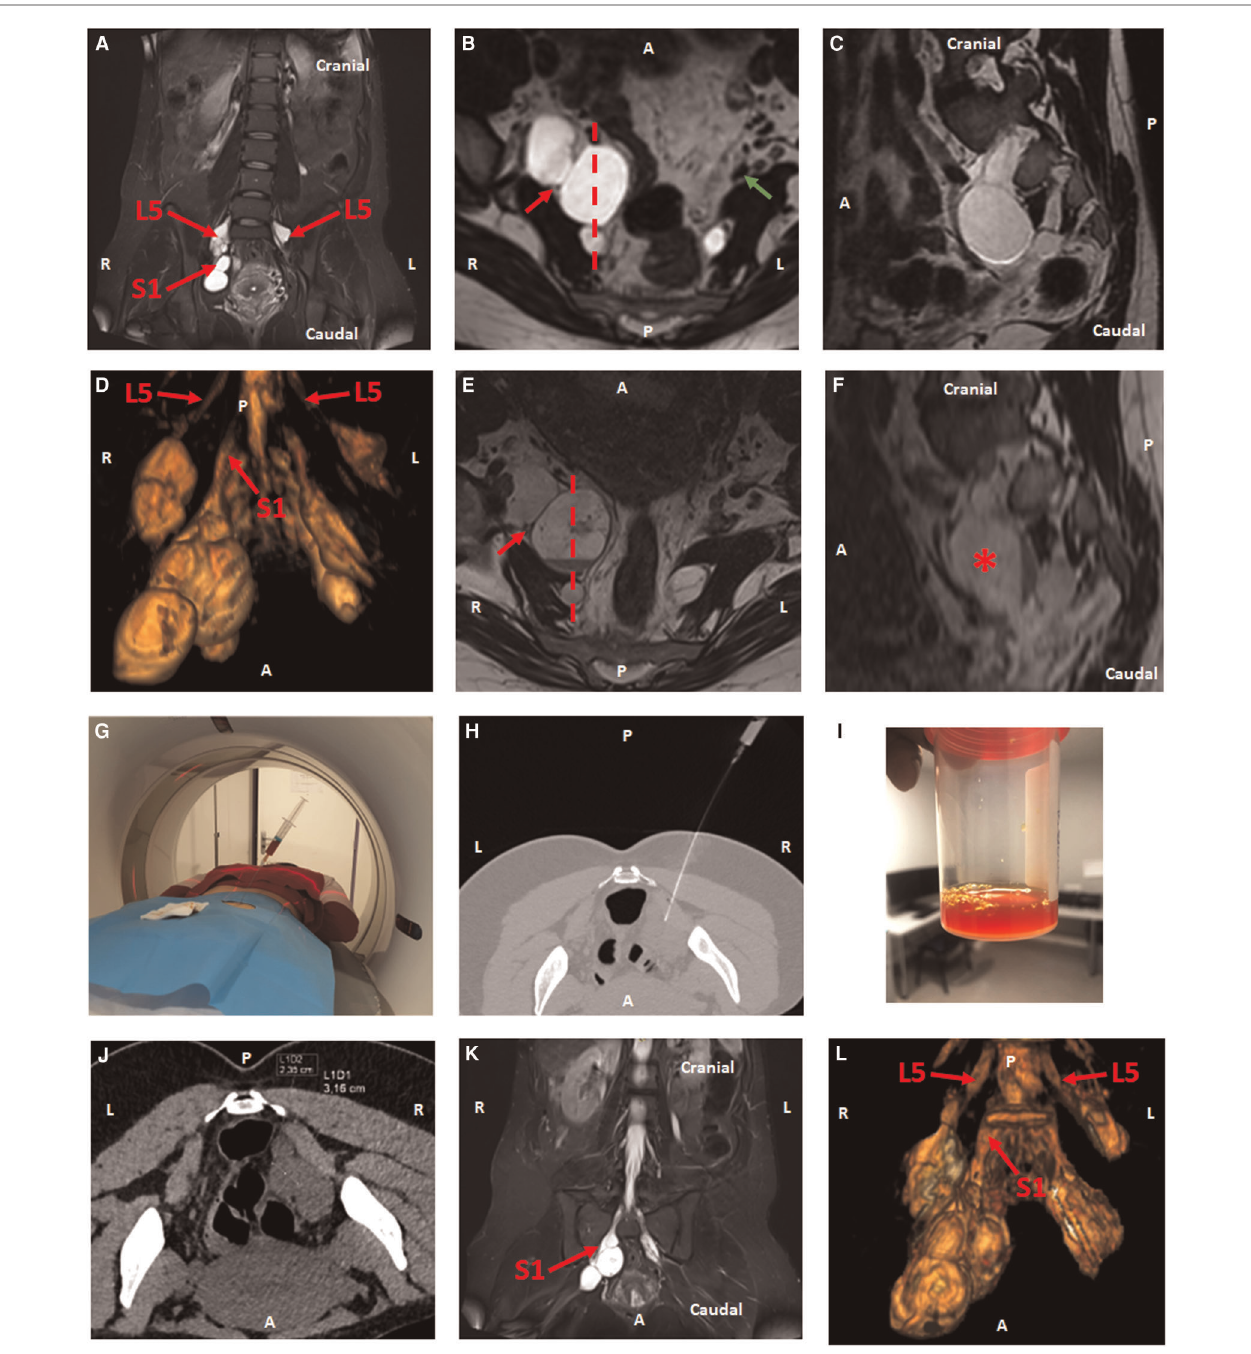
FIGURE 1 | Presence of large bilateral sacral radicular cysts on MRI coronal ( A ), axial ( B ) and sagittal ( C ) T2-weighed sequences predominantly on the right L5 and S1, S2 and S3 roots (red arrows) and on the left L5 root ( A ). ( C ) correspond to dotted plane in ( B ). ( B ) Pelvic cystic formation of 36×29 mm on the right S1 nerve root (MRI axial view T2-weighed sequence), right (red arrow) and left (green arrow) sciatic nerves. ( D ) 3D reconstruction of the different cysts associated with the different nerve roots. Fluid- fl uid level, on axial ( E ) and sagittal ( F ) T2-weighed sequences. ( F ) correspond to dotted plane in ( E ). Bleeding was noticed predominantly on the right L5 and S1 cysts (red asterisk) and appearing to sheath the distal portion of right S1 (red arrow). This intracystic hemorrhagic complication was probably due post- partum ( G,H ) Aspiration of a hemorrhagic liquid under pelvic-abdominal CT-scan guidance. ( I ) Fluid aspect. ( J ) Dimensions of this hemorrhagic cyst immediately after aspiration (CT-scan axial view): 31×25 mm. ( K ) MRI control 1 year after the procedure, with 3D reconstructions ( L ). Remodeling of the cyst was observed. A reduction of 7% of its initial volume was determined by volumetric analysis before and after the procedure, and the S1 root is better visualized. R=Right, L= Left, A=Anterior,